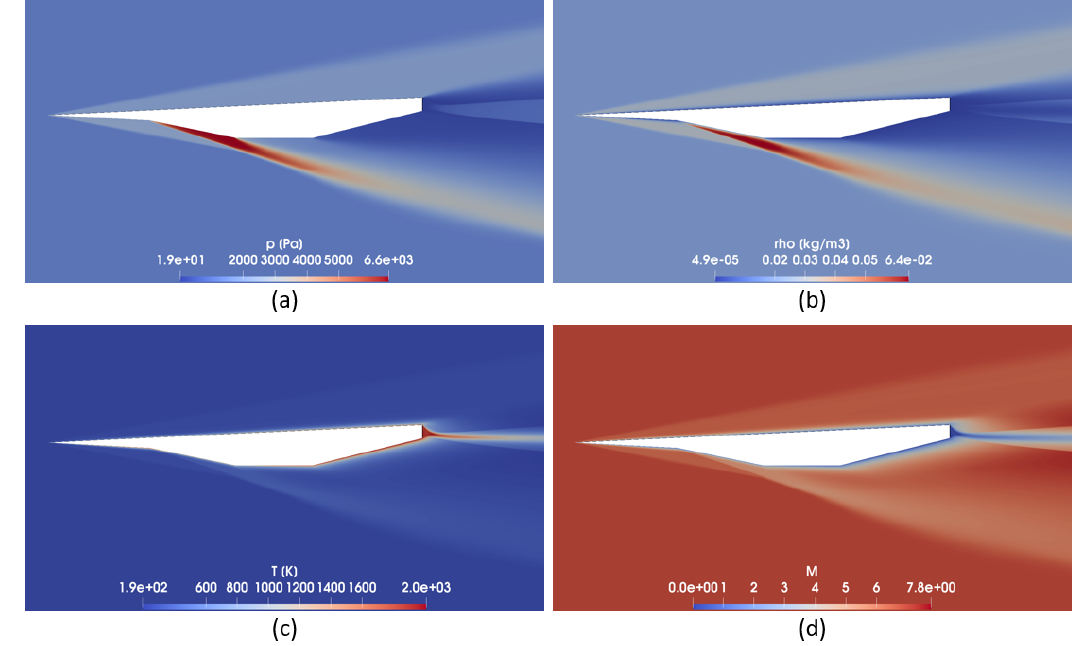
Figure 3. Pressure field ( a ), density field ( b ), temperature field ( c ) and Mach field ( d ) of the CFD case with the scramjet neglected for AoA = 0 ◦